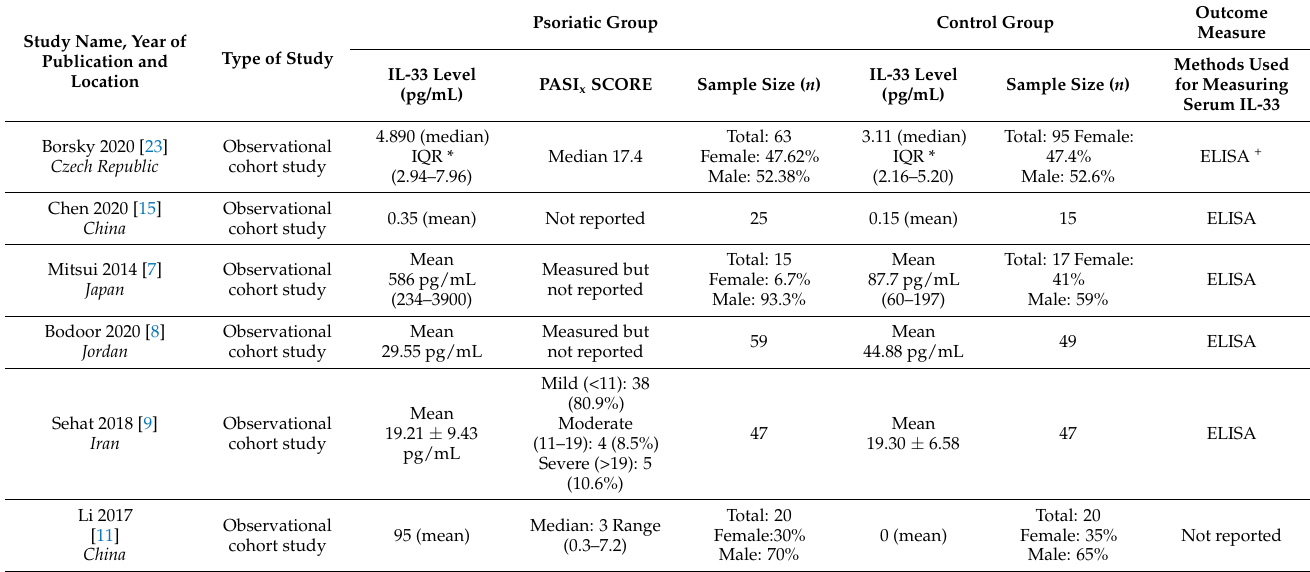
Table 2. Characteristics of the included studies